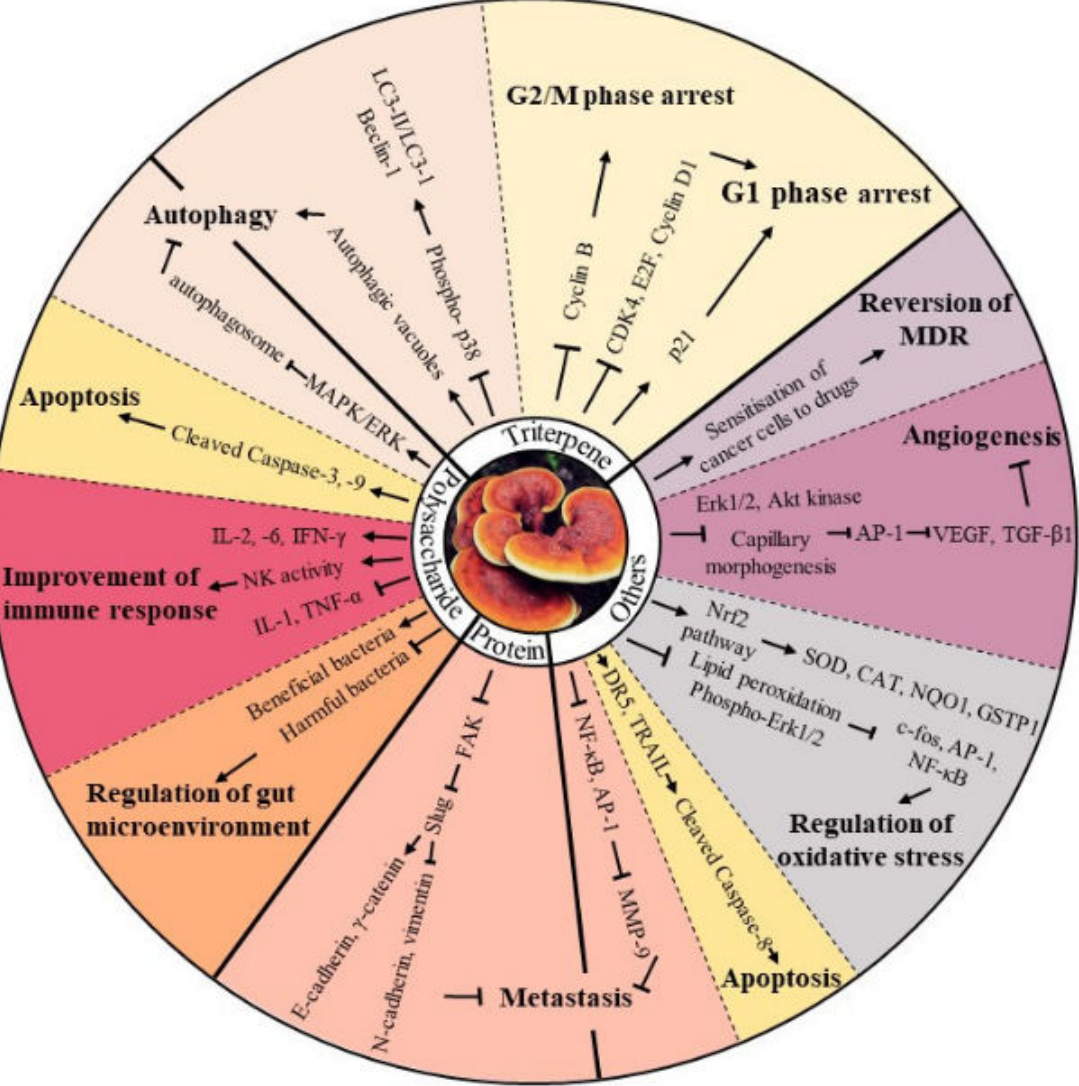
Figure 1. An overview of the numerous anti-tumour bioactivities of Ganoderma lucidum . Pharmaceutically active components isolated from Ganoderma lucidum demonstrated potent anti-tumour bioactivities through multiple signalling pathways. “ ↑ ” represents activate, promote, stimulate or up-regulate, while “ Т ” represents inhibit, suppress, decrease or